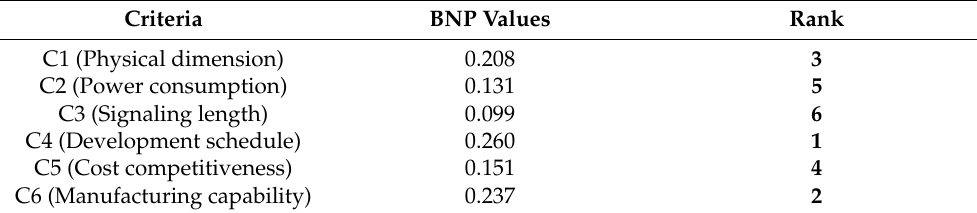
Table 5. Best nonfuzzy performance (BNP) values of the criteria.